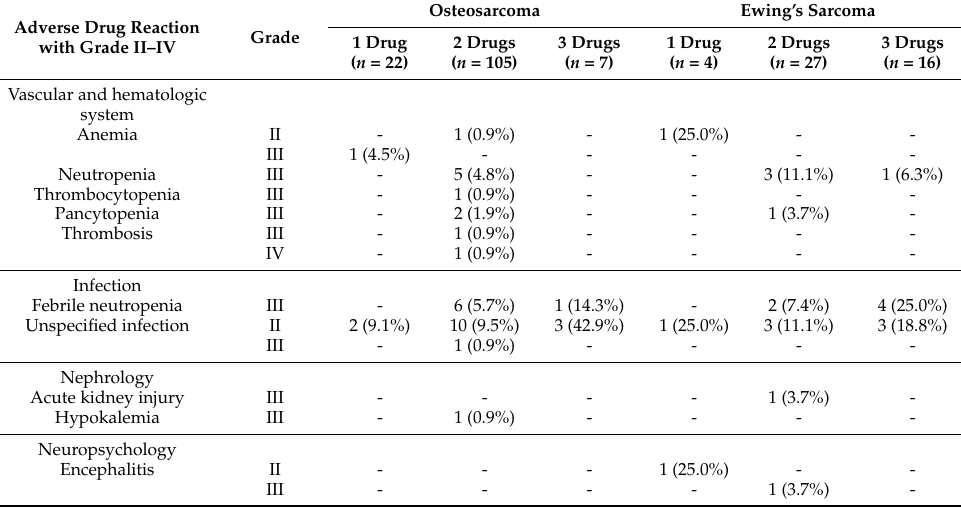
Table 5. Adverse drug reactions following chemotherapy